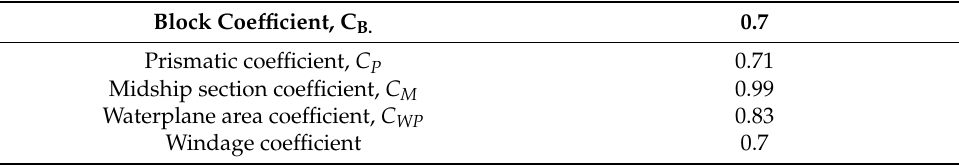
Table 4. Hull form